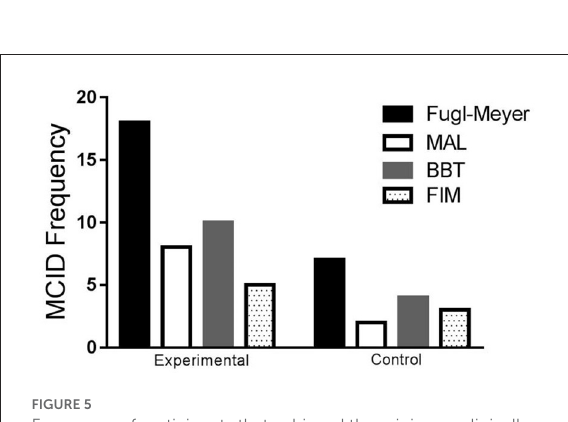
FIGURE5 Frequency of participants that achieved the minimum clinically important difference in both groups for the Fugl-Meyer, MAL, BBT, and FIM. MCID, minimal clinically important difference; MAL, motor activity log (MCID 1.0); Fugl-Meyer (MCID 5.25); BBT, box and blocks test (MCID 5.5/min); FIM, functional independence measure (MCID 22).